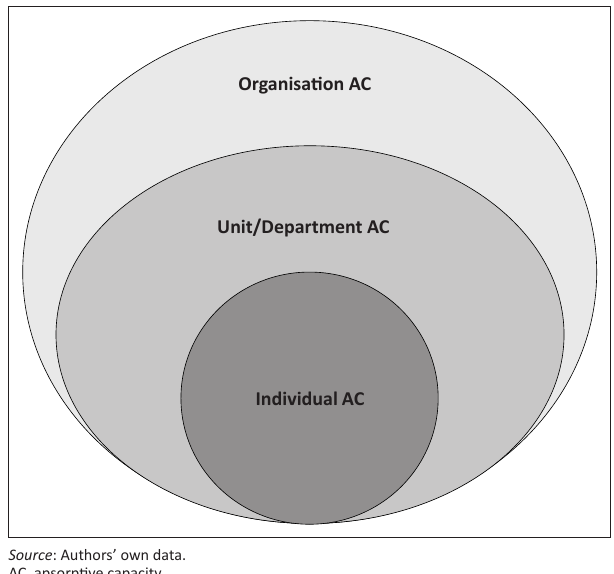
FIGURE 2: An Organisation’s Levels of Absorptive Capacity